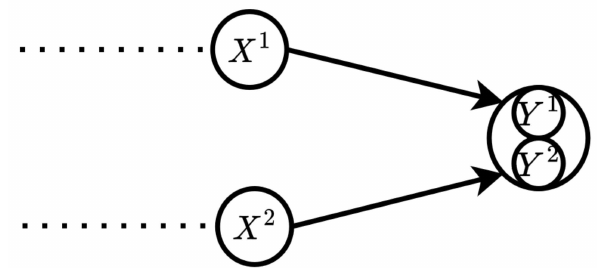
Figure 8. Double-chain subgraph of Example 2.